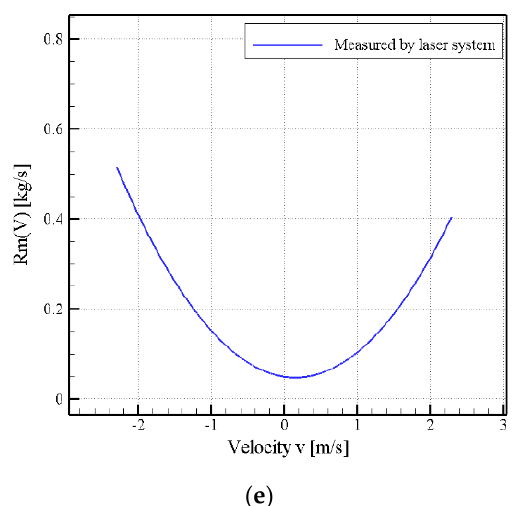
Figure 11. Comparison of nonlinear parameter curves obtained using different methods and laser displacement measurement system. ( a ) Bl ( x ), ( b ) K m ( x ), ( c ) L e ( x ). (Note: Laser dependent on right scale), ( d ) R m ( x ), and ( e ) R m ( v ). (Note: R m ( v ) was used in measurement of R m ( x ) using the laser displacement measurement system; thus, another comparison is made).